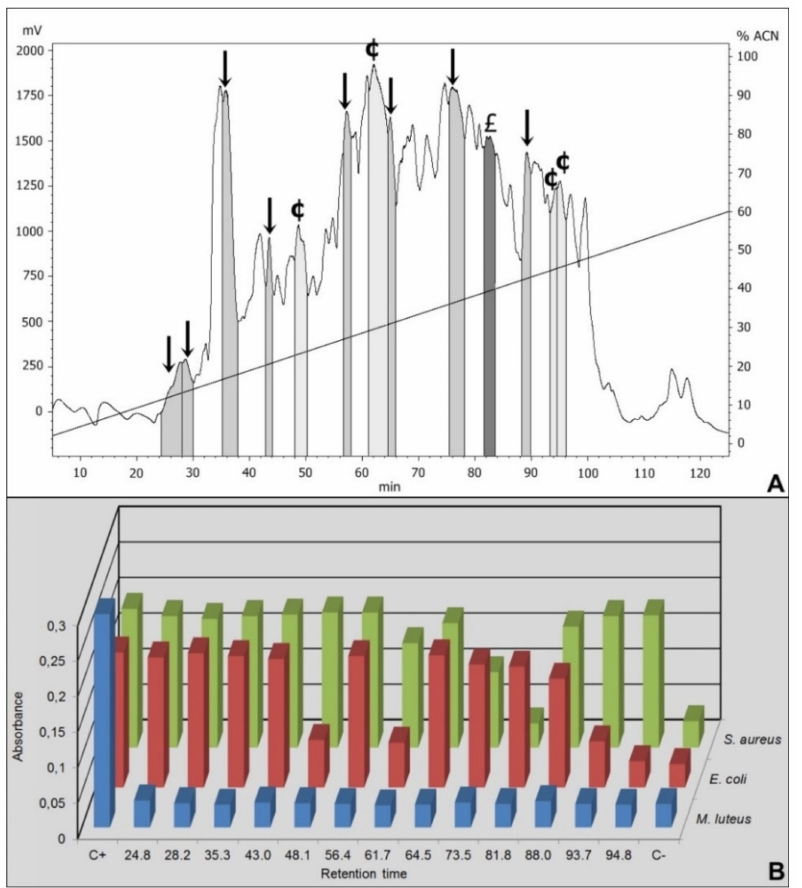
Figure 1. RP-HPLC chromatogram and antimicrobial growth inhibition of 40% ACN Sep-Pack elution samples. ( A ) The fractions isolated from Triatoma infestans intestinal content were separated by RP-HPLC using a C 18 column, eluted with a linear gradient from solution A from 2% to 60% of the solution B run for 120 min. The labeled fractions ( ↓ ), eluted at 24.8 min, 28.2 min, 35.3 min, 43 min, 56.4 min, 64.5 min, 75.3 min and 88 min, exhibited antimicrobial activity against Micrococcus luteus . The labeled fraction (£) eluted at 81.8 min exhibited antimicrobial activity against Micrococcus luteus and Staphylococcus aureus . The labeled fractions ( ¢ ), eluted at 48.1 min, 61.7 min, 93.7 min and 94.8 min, presented antimicrobial activity against M. luteus and Escherichia coli. ( B ) The absorbance registered after the incubation of the RP-HPLC eluted fractions with M. luteus, E. coli and S. aureus. C + is the positive control for